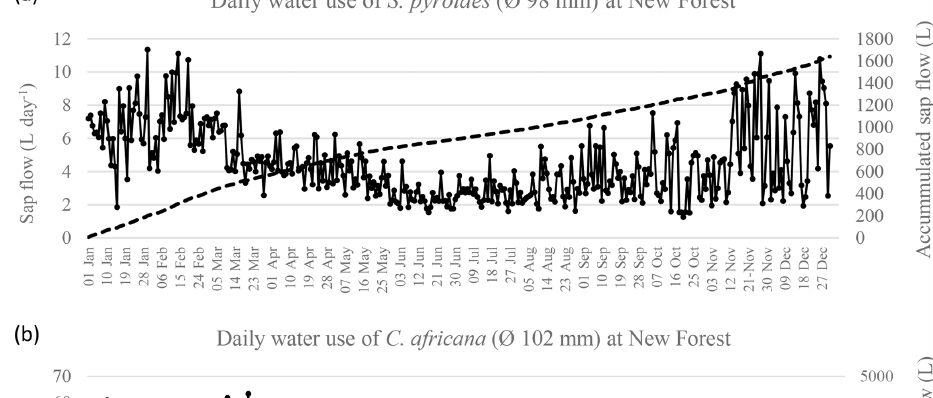
10 % in the upper horizons. At the introduced site 2, the soils were uniform throughout the horizons. During the summer periods, the profile soil water averaged 27 %, whereas it de- pleted to 9 % or 11 mm of water per 100 mm depth of soil during the dry